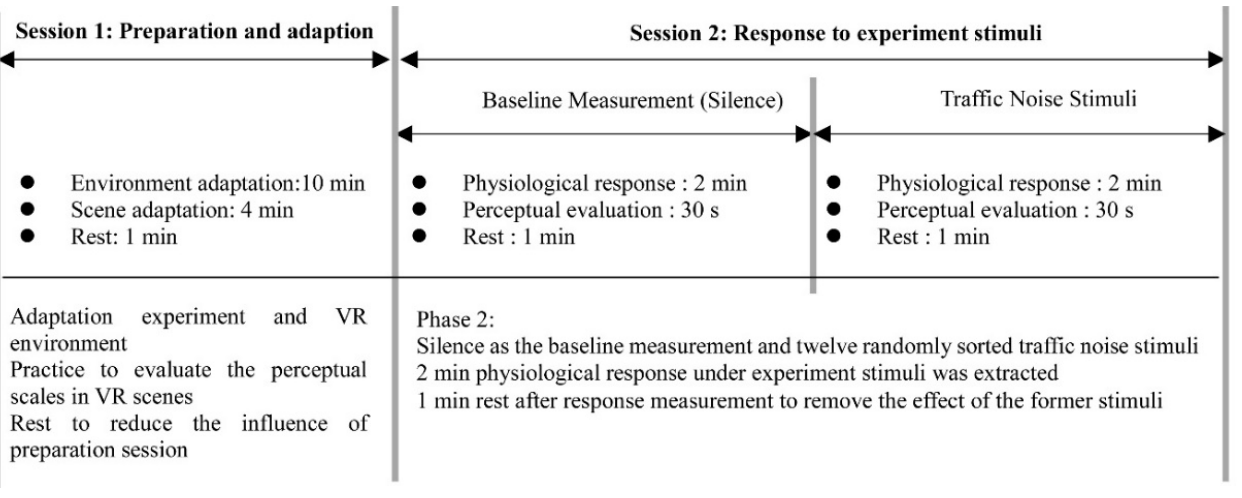
Figure 3. Schematic diagram of the experiment process.